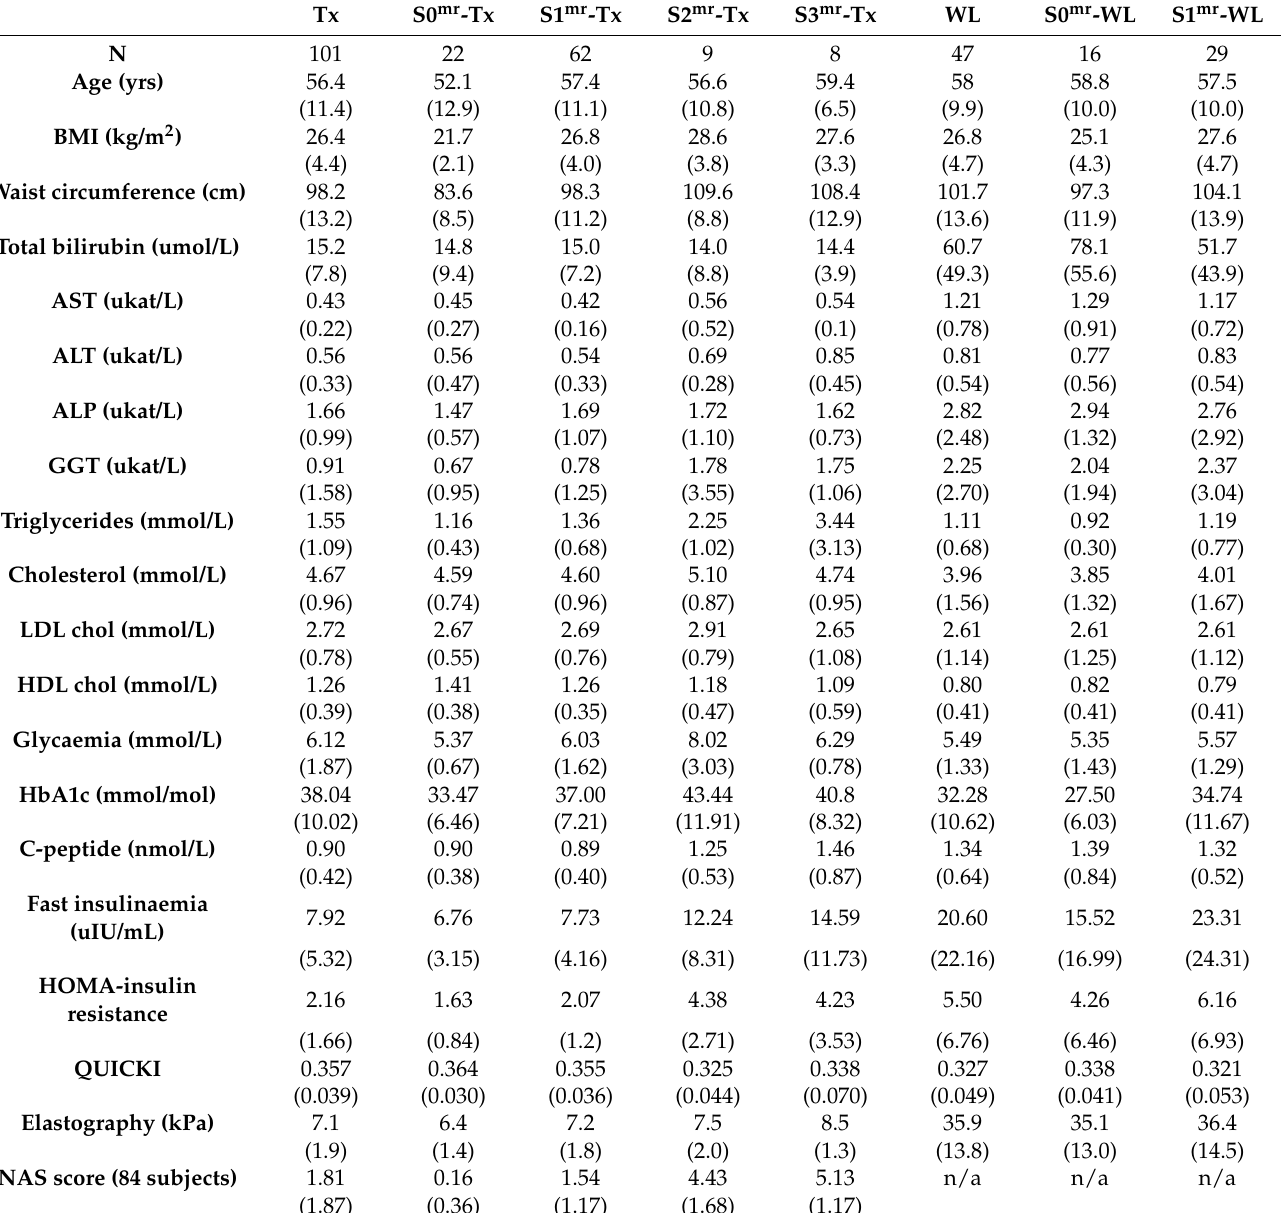
Table 4. Clinical and laboratory data and results of elastography of patients before (WL) and after (Tx) LT classified by steatosis grade (S0 mr , S1 mr , S2 mr , S3 mr ) evaluated by MR spectroscopy. Standard deviations are in